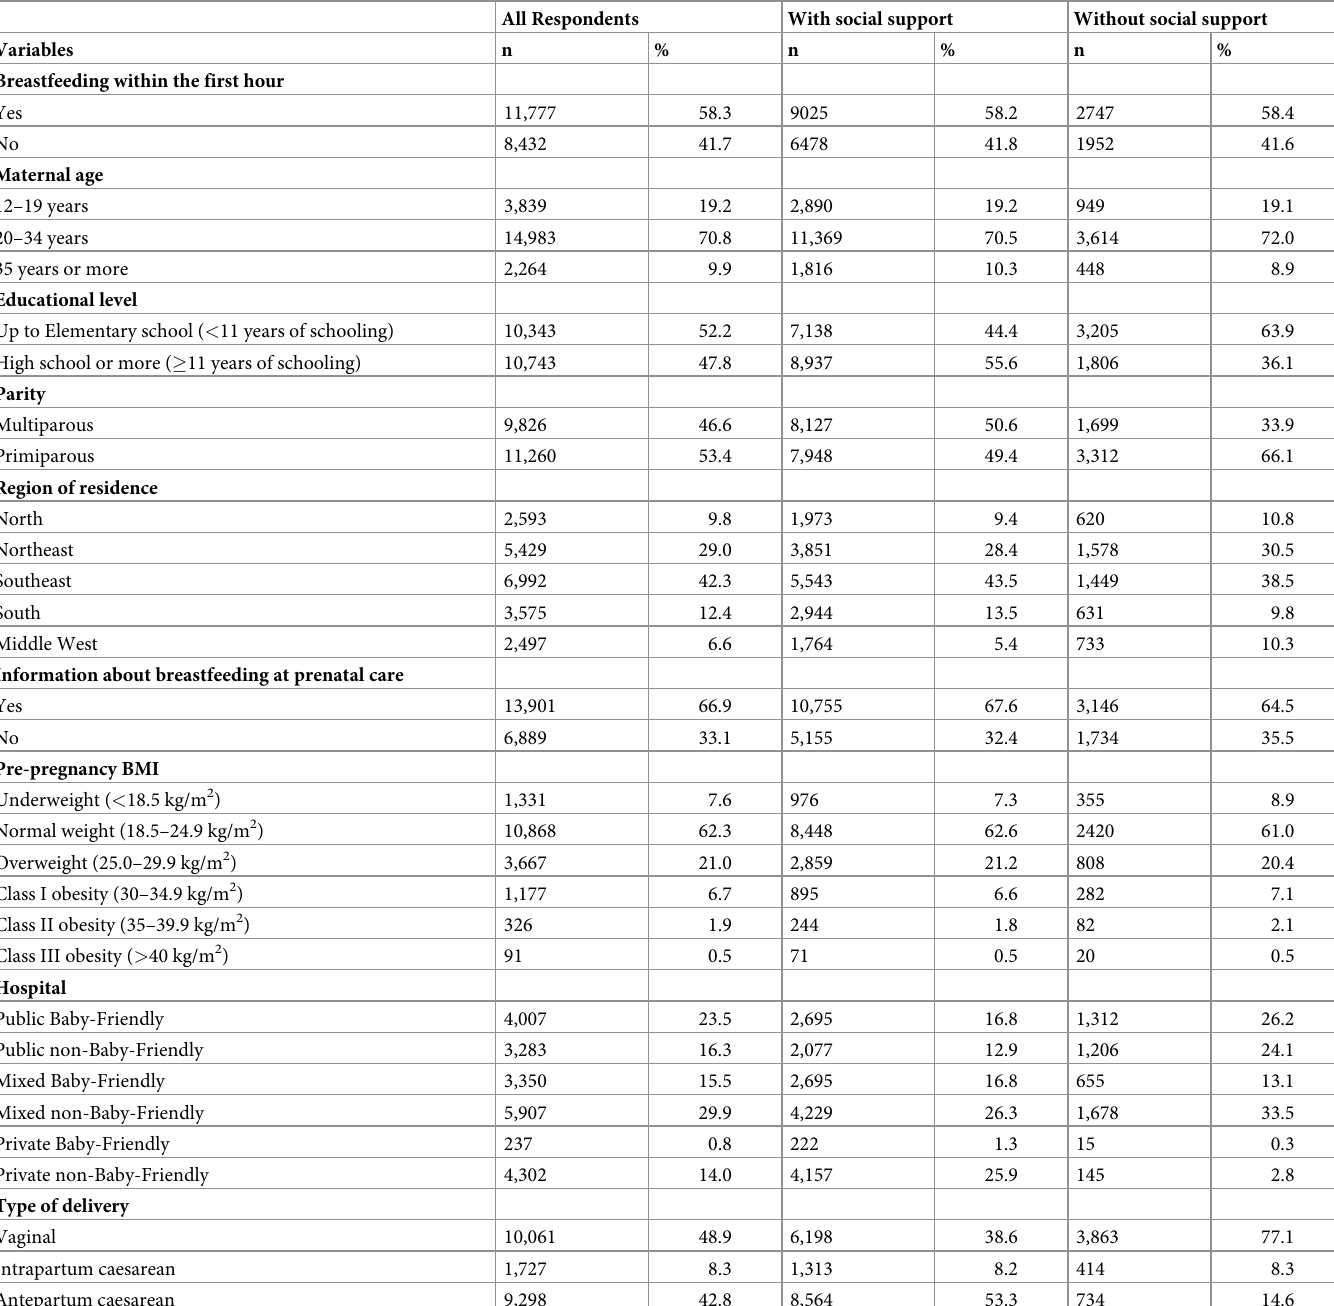
Table 1. Prevalence of breastfeeding within the first hour after birth and maternal, hospital and child characteristics by social support status, Brazil, 2011. All